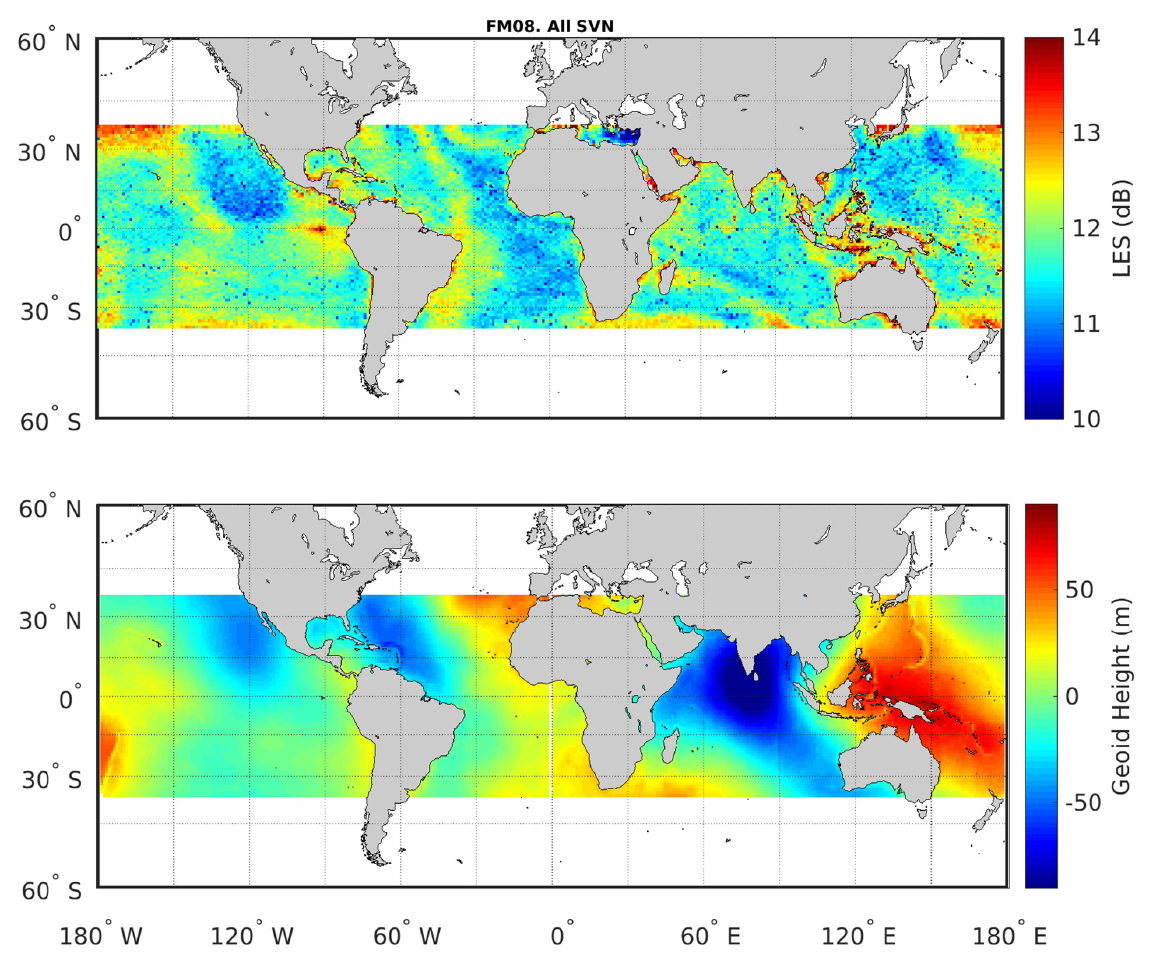
Figure 7. ( top ) Geographical distribution of leading edge slope (LES) at U10 ~7m/s reported by FM03 averaged across all SVNs over August 2018–December 2019; ( bottom ) global map of geoid (EGM 2008) [22].